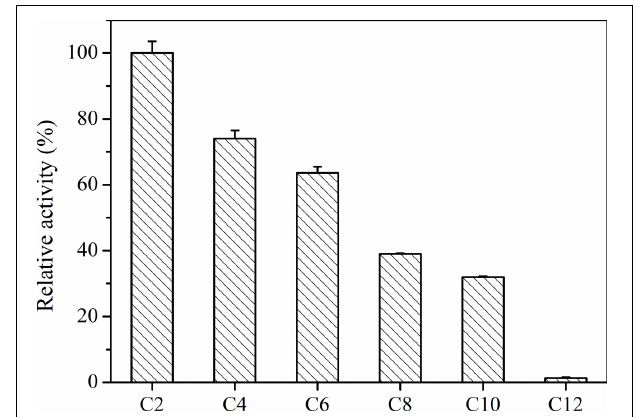
FIGURE 4 | Substrate specificity of Aii810 against various ρ -nitrophenyl esters with acyl chain lengths of C2, C4, C6, C8, C10, and C12. Data points are the average of triplicate measurements, and error bars represent the standard